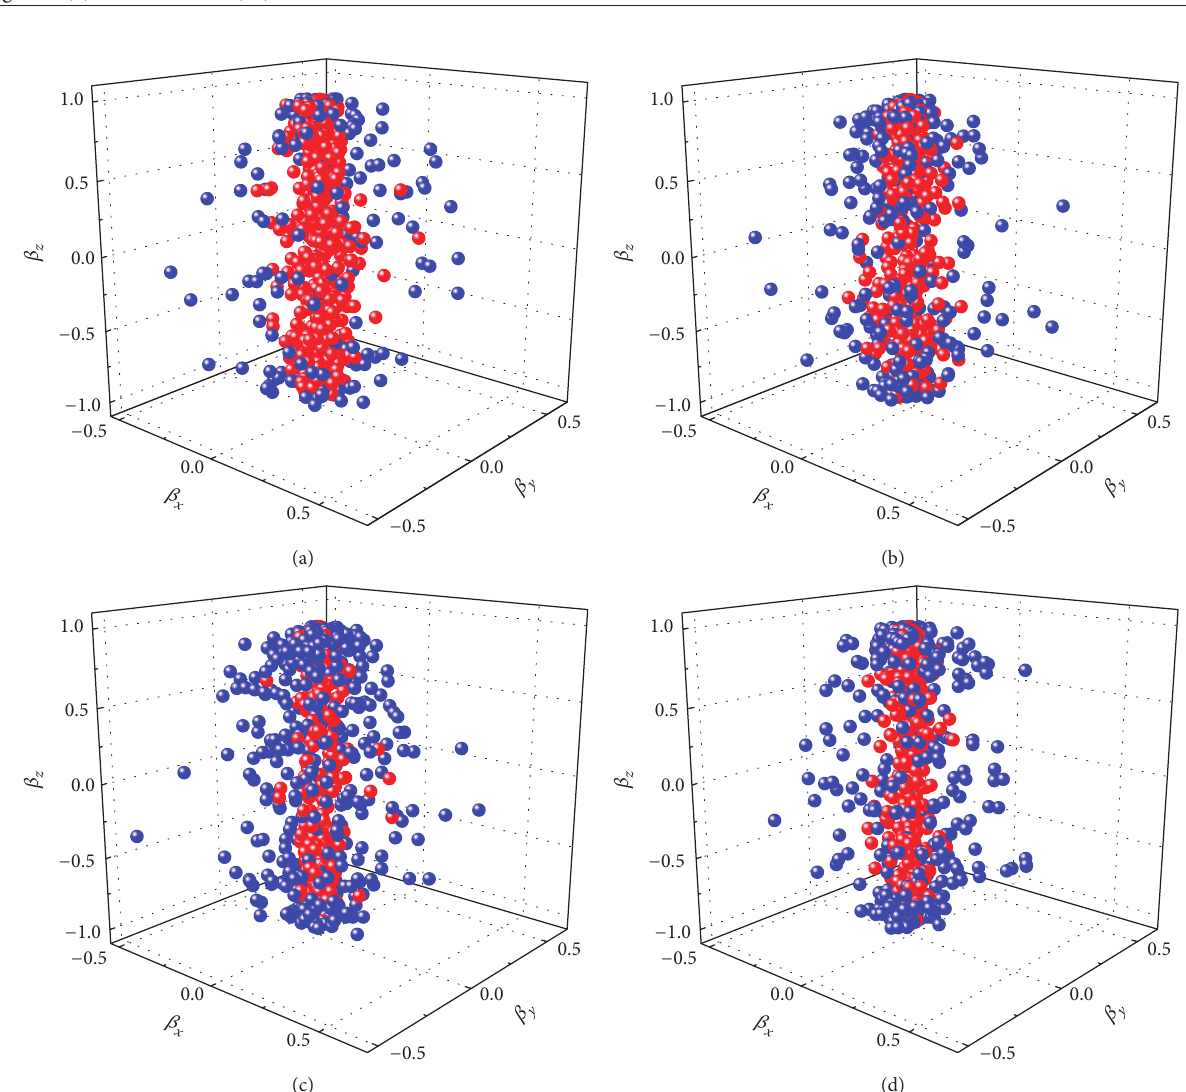
Figure 4: Event patterns in three-dimensional velocity ( 𝛽 𝑥 - 𝛽 𝑦 - 𝛽 𝑧 ) space in (a)-(b) pp collisions at √𝑠 = 2.76 TeV and (c)-(d) Pb-Pb collisions at √𝑠 NN = 2.76 TeV, for the (a)-(c) dimuon and (b)-(d) dielectron decay channels. The number of 𝑍 bosons for each panel is 1000. The red and blue globules represent the results of the first and second components in the two-component Erlang distribution for 𝑝 𝑇 , respectively. The contributions of the first and second components in the two-component Gaussian distribution for 𝑦 are not distinguished by